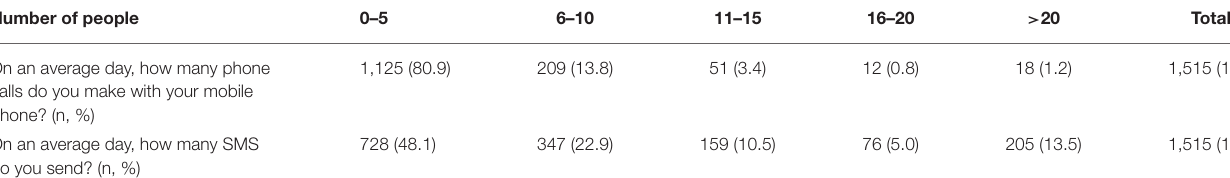
TABLE 3 | Average daily mobile phone